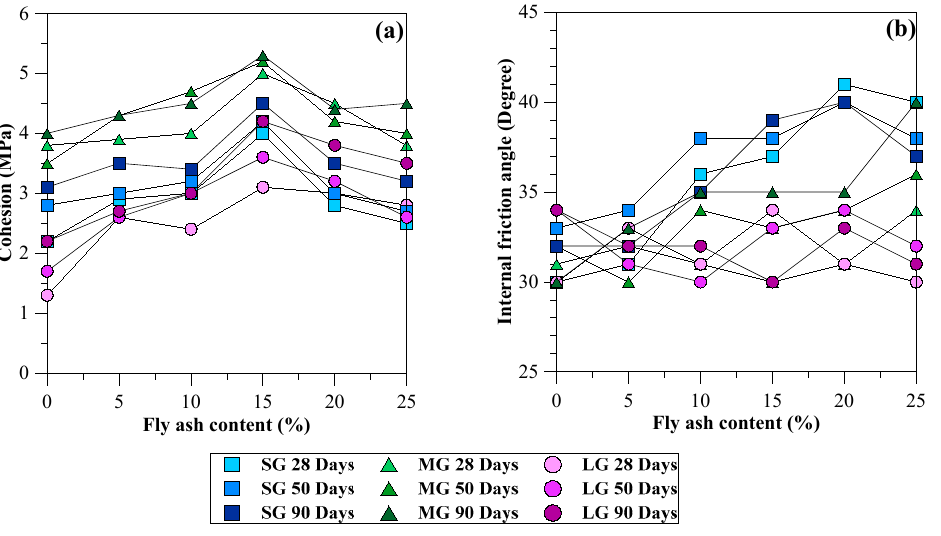
Figure 12. Relationships of ( a ) cohesion and fly ash content, ( b ) internal friction angle and fly ash content .